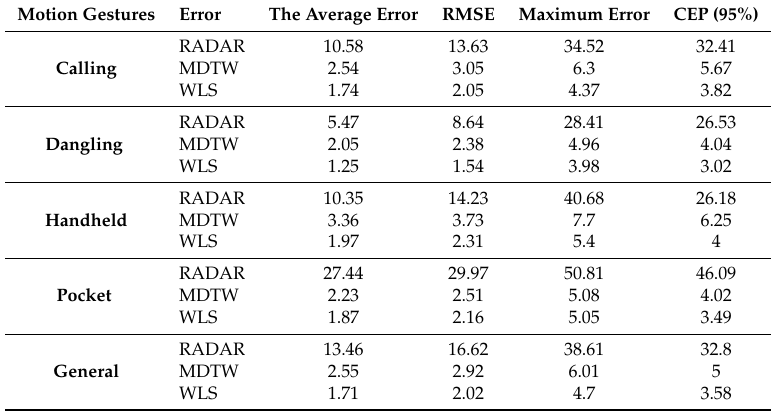
Table 2. Position errors for RADAR, MDTW, and WLS (m).